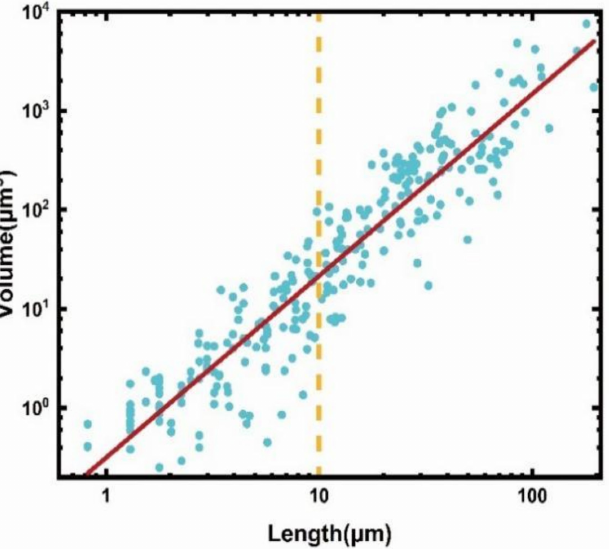
Figure 7. The length and volume